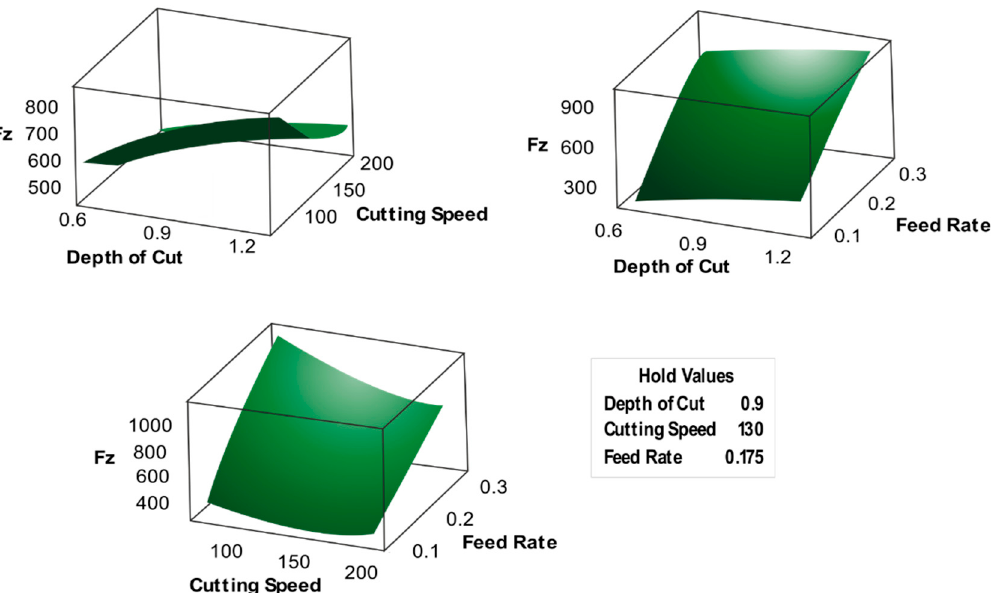
Figure 8. Response surface plot for F z .